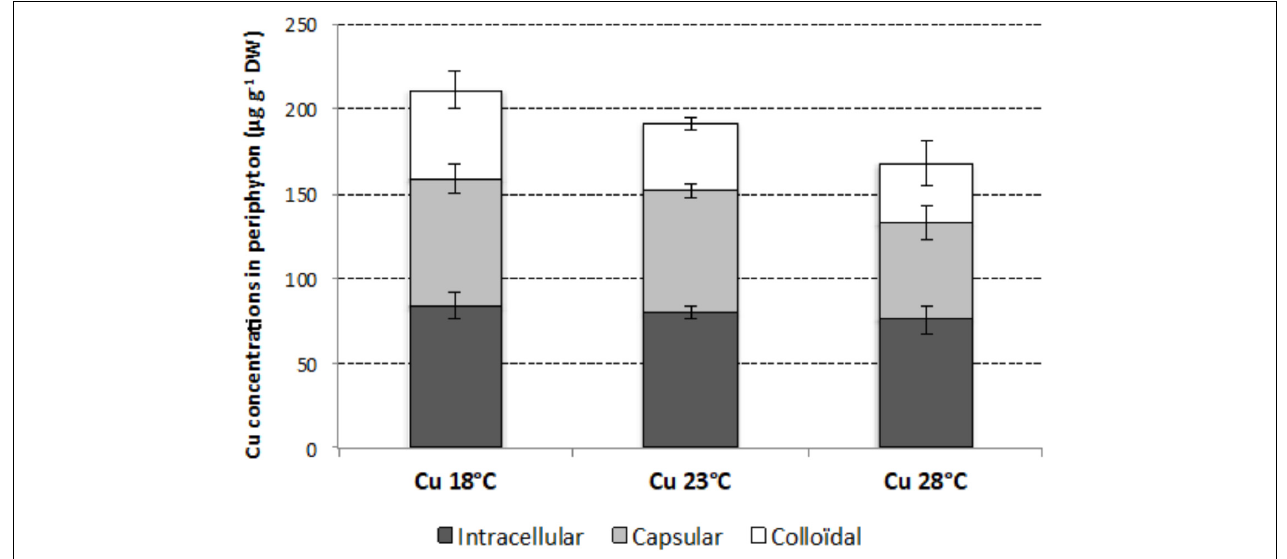
FIGURE 2 | Mean ( ± SD; n = 3) intracellular, capsular, and colloidal concentrations of Cu in periphyton ( µ g g − 1 dry weight) at week 4, in the Cu-exposed microcosms incubated at 18, 23, and 28 ◦